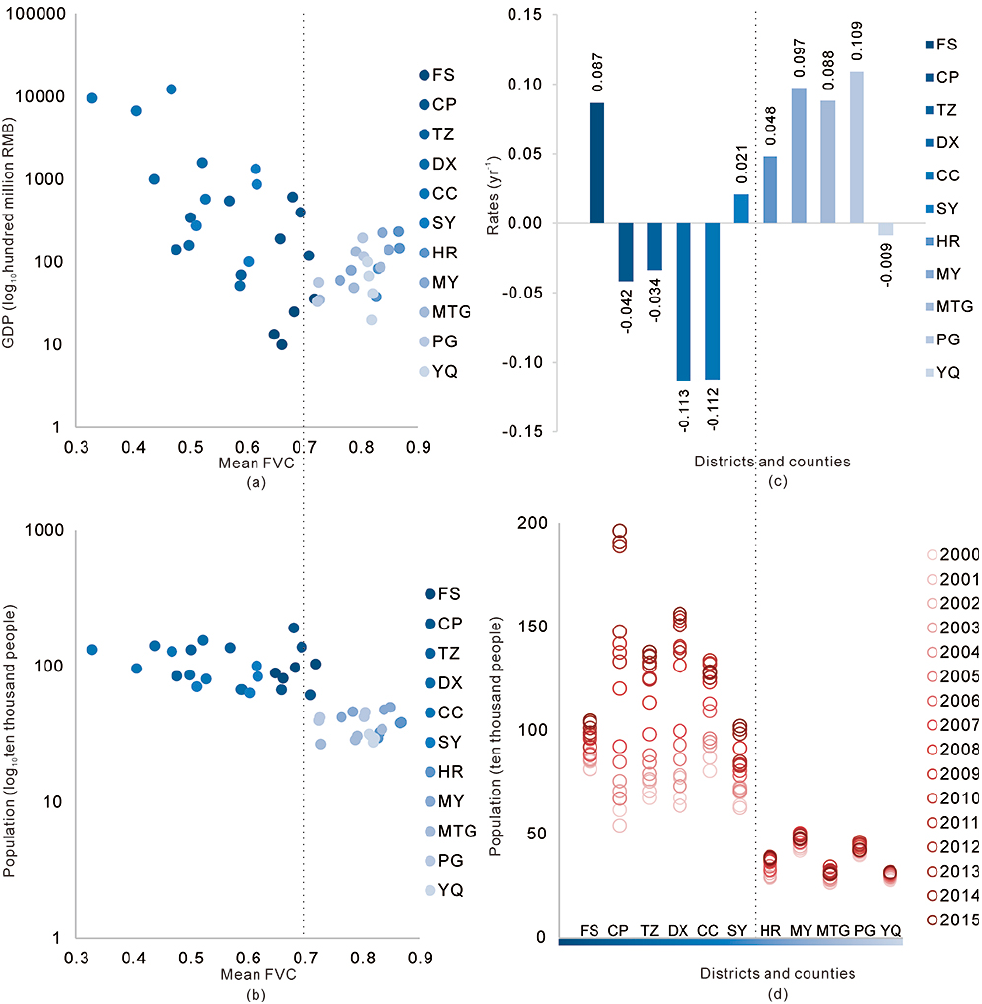
Figure 9. ( a ) Correlation relationships between GDP and FVC at a district and county level in 2000–2015; ( b ) Correlation relationships between population and FVC at a district and county level in 2000–2015; ( c ) FVC change rates at a district and county level during 2000–2015; ( d ) Population at a district and county level. The y-axis of ( a , b ) are logarithmic coordinates. Table 5. Correlations between vegetation cover changes and socioeconomic factors in T-C and H-Y. Change from Correlation Significance Partial Correlation Significance 2000 to 2015 Coefficients ( p -Value) Coefficients ( p -Value) population in H-Y